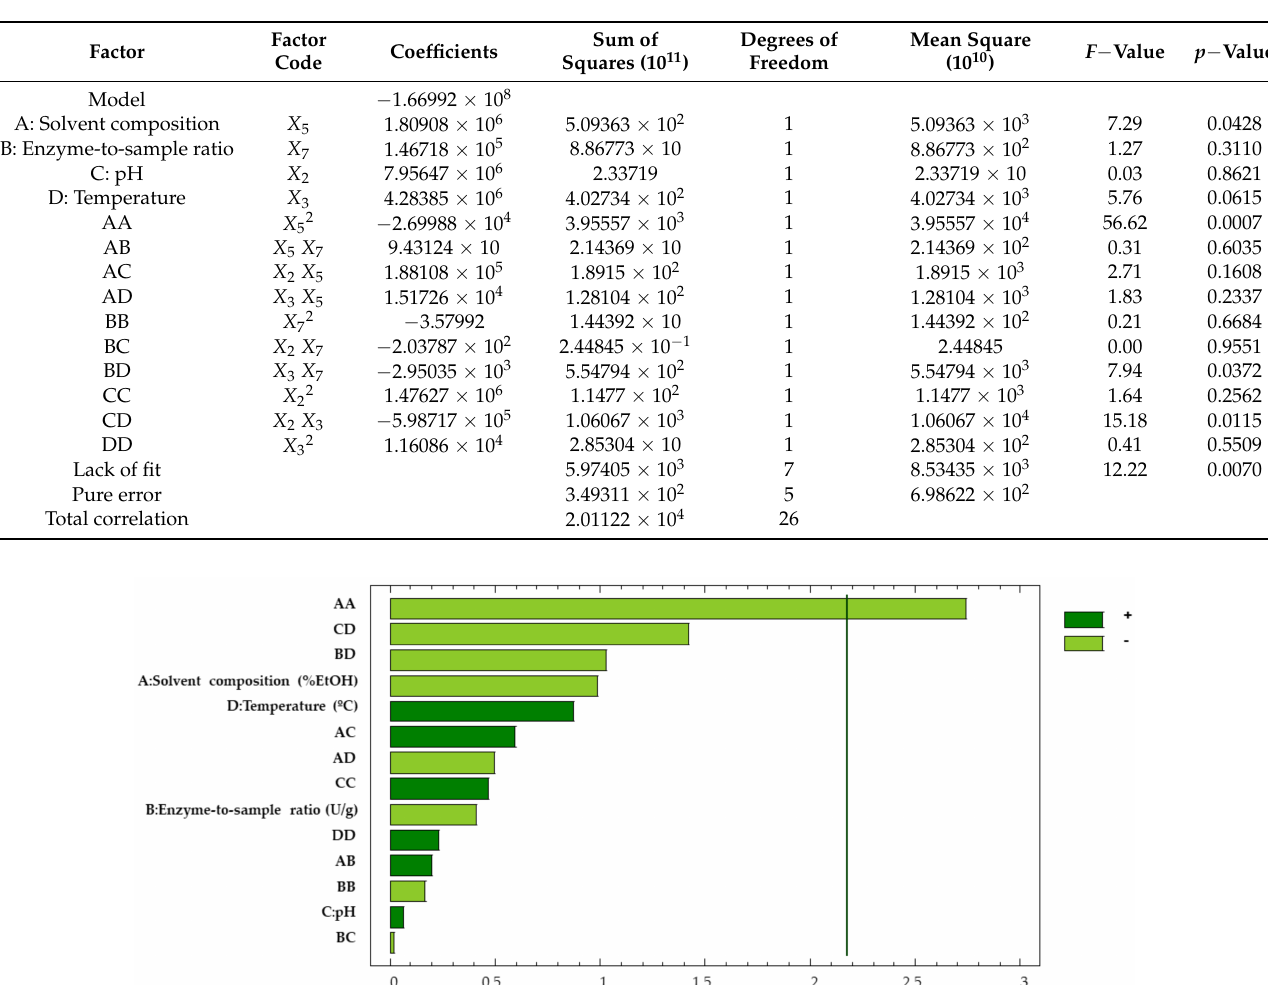
Table 4. ANOVA of the Box–Behnken surface-response design.